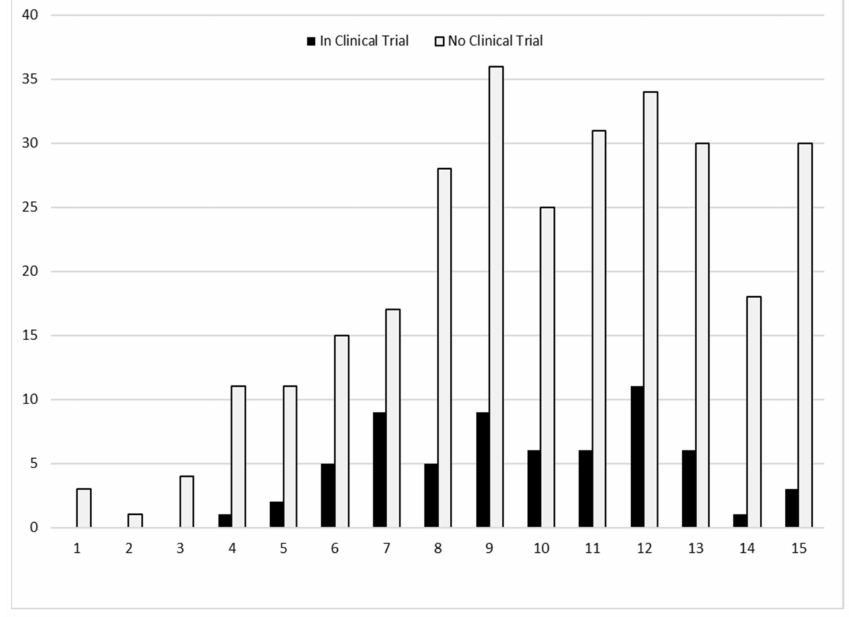
Figure 3. Number of individuals by age (years) in 2015 and clinical trial participation during 2000–2015, the Muscular Dystrophy Surveillance, Tracking, and Research Network (MD STAR net